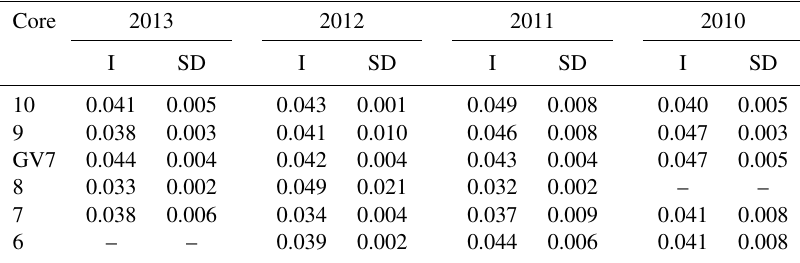
Figure 6. Variability of δ 18 O (upper panel), Na (middle top panel, left axis), Br (middle top panel, right axis), Brenr (middle bottom panel, left axis), nssBr (middle bottom panel, right axis) and I (bottom panel) in cores 7 (left) and 6 (right). Thick lines represent 3-month running means of the raw data (circles).